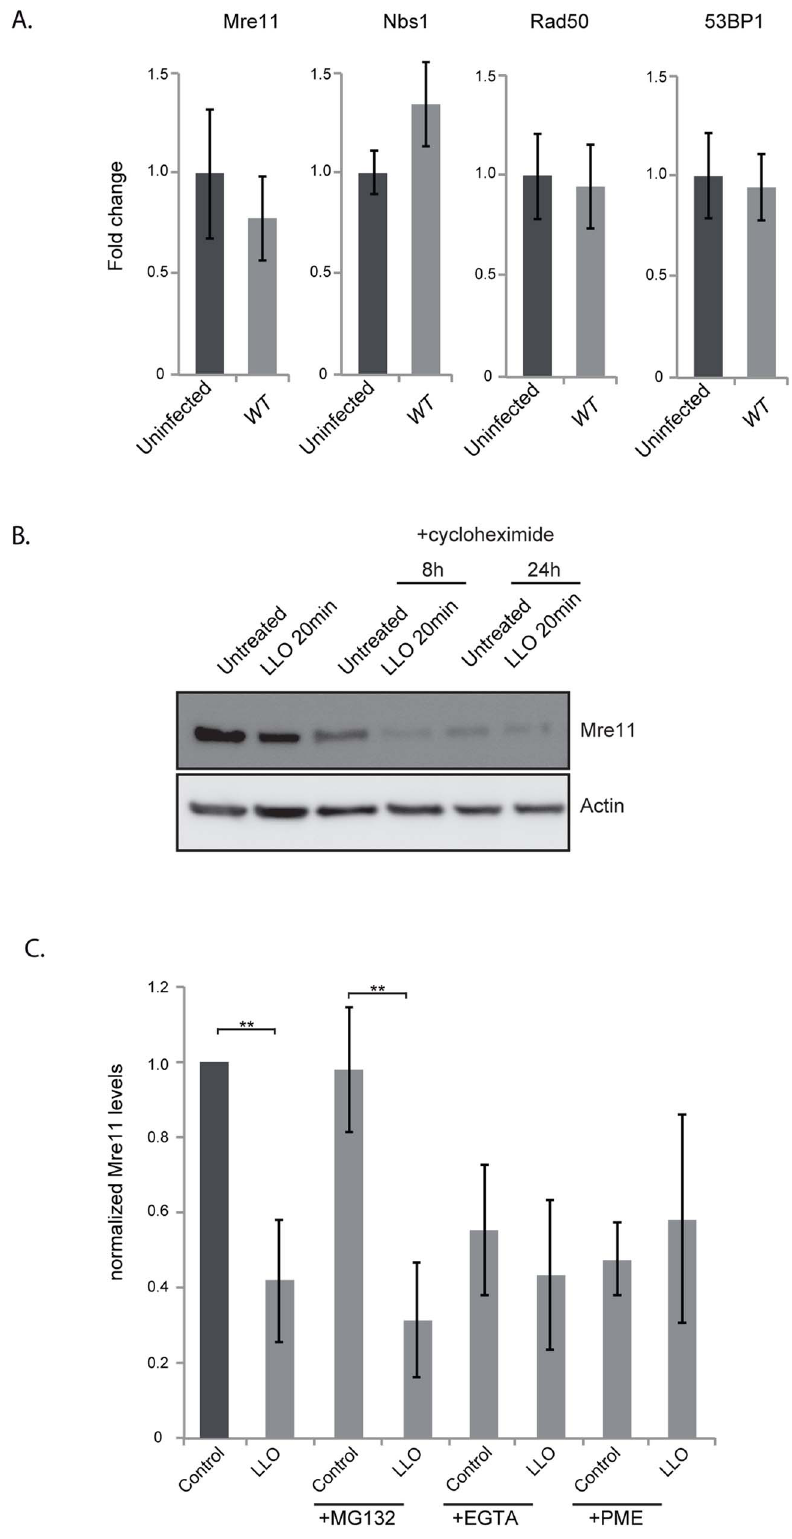
Figure 5. LLO induces degradation of Mre11 in an aspartyl-protease dependent manner. (A) Quantitative PCR experiments comparing uninfected HeLa cells to cells infected for 24 h with wild type L. monocytogenes . Error bars are standard deviation as calculated by the Qiagen RT2 Profiler PCR analysis program. (B) Immunoblot of HeLa cells treated with cycloheximide for the indicated times. (C) Quantification of immunoblots of cells treated with the indicated inhibitors. For all experiments LLO was used at 3 nM for 20 minutes. All quantifications in graphs show the mean + / 2 SEM (** indicates p , 0.01). doi:10.1371/journal.ppat.1004470.g005 PLOS Pathogens | www.plospathogens.org 8 October 2014 | Volume 10 | Issue 10 |